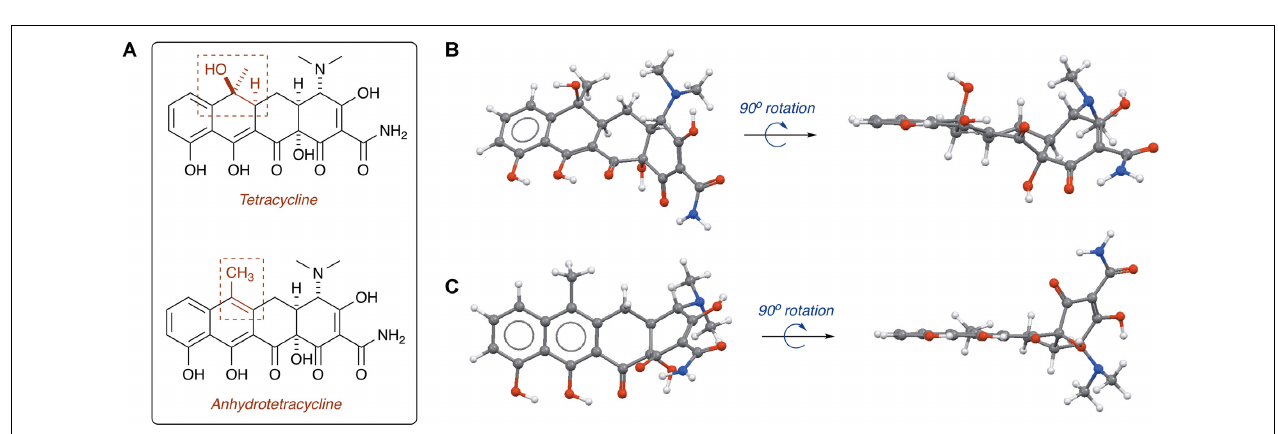
FIGURE 11 | (A) Structures of tetracycline (top) and anhydrotetracycline (bottom). Conformation of tetracycline (B) and anhydrotetracycline (C) as viewed from face and edge of the tetracyclic core. 3D structures of tetracycline and anhydrotetracycline in panels (B) and (C) were energy minimized using Spartan and images were generated using Mercury software